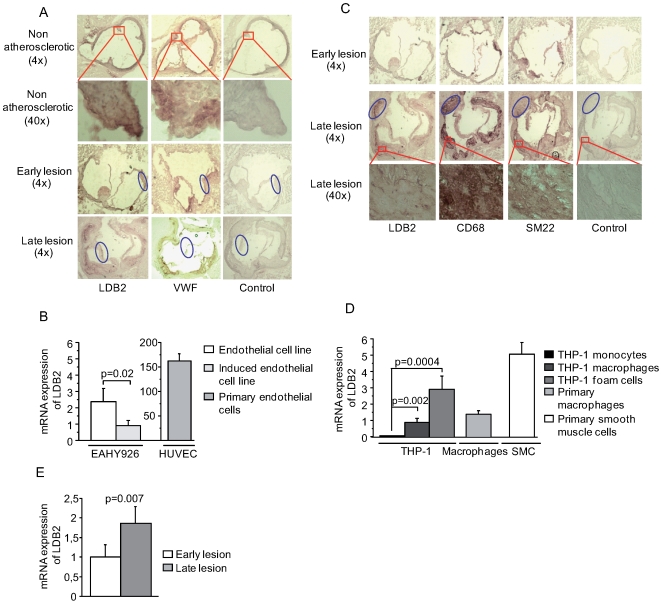
LDB2 expression in atherosclerotic lesions and cultured lesion cell types.Total RNA was isolated from cell cultures and mouse aortic arch (third rib to aortic root). Consecutive mouse aortic root sections were incubated with goat anti-LDB2, rat monoclonal anti-mouse CD68, rabbit polyclonal anti-mouse SM22 alpha, or rabbit polyclonal anti-human VWF at 4°C overnight and counterstained with hematoxylin. RT–PCR was performed on total RNA isolated from human pulmonary artery SMCs, THP-1 monocytes, THP-1 macrophages generated with phorbol 12-myristate 13-acetate, THP-1 foam cells cultured from THP-1 macrophages incubated with acetylated low density lipoproteins, primary macrophages differentiated from primary monocytes isolated from human blood with AB serum, cultured EAHY926 cells, EAHY926 cells induced with 20-ng/ml human recombinant TNF-α, and HUVECs isolated with collagenase. (A) Mouse LDB2 and VWF protein expression in serial sections of aortic roots from Ldlr
−/−
Apob
100/100 mice at 10 weeks (arterial wall without visual atherosclerosis, “non-atherosclerotic”), 20 weeks (early lesions, fatty streaks), and 50 weeks (late lesion, plaques). Ovals indicate areas of overlapping LDB2 and VWF staining in relation to negative controls. (B) LDB2 mRNA levels in EAHY926 cells, induced EAHY926 cells, and HUVECs (n = 4 per cell type; scales on Y-axes are comparable because the RT-PCR was performed in one single run). (C) Mouse LDB2, CD68, and SM22 alpha protein expression in serial sections of aortic roots from Ldlr
−/−
Apob
100/100 mice at 20 and 50 weeks. (D) LDB2 mRNA levels in primary human SMCs, THP-1 monocytes, THP-1 monocytes differentiated into THP-1 macrophages, THP-1 foam cells, and primary human monocytes differentiated into macrophages (n = 4 per experiment). Ovals indicate areas of overlap between LDB2 and CD68 but no or very subtle SM22 staining in relation to negative controls. (E) mRNA levels measured by real-time PCR from late (40 weeks, plaques, n = 5) and early (20 weeks, fatty streaks, n = 5; lesions from the aortic arch in Ldlr
−/−
Apob
100/100 mice.